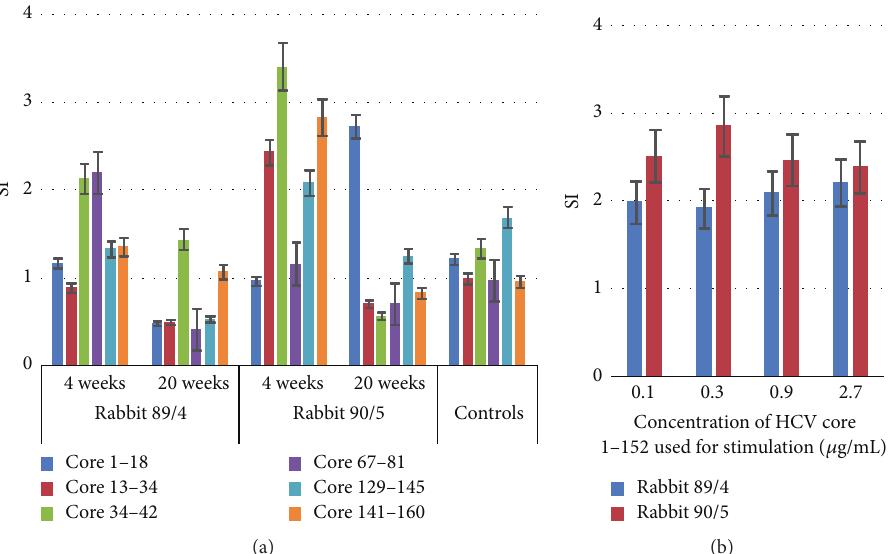
Figure 4: Proliferative response to HCV core in rabbits immunized with HCV core 1–152 visualized as stimulation indexes (SI). Stimulation of PBMCs of rabbits 89/4 and 90/5 with synthetic peptides derived from core 1–152 two weeks after prime (week 4) and two weeks after the last boost (week 20); controls are na¨ıve rabbits ( 𝑛 = 3 ) and rabbits were immunized with irrelevant protein antigens ( 𝑛 = 4 ) (a); low or no dependence of T-cell stimulation on the concentration of HCV core 1–152 used in proliferation test in the test done prime (week 4) (b). All antigen stimulation tests were performed in triplicate. Test results were discarded if radioactivity incorporation values demonstrated by mitogen PHA were below 1000 counts per minute and if stimulation indexes in response to PHA were below 2.